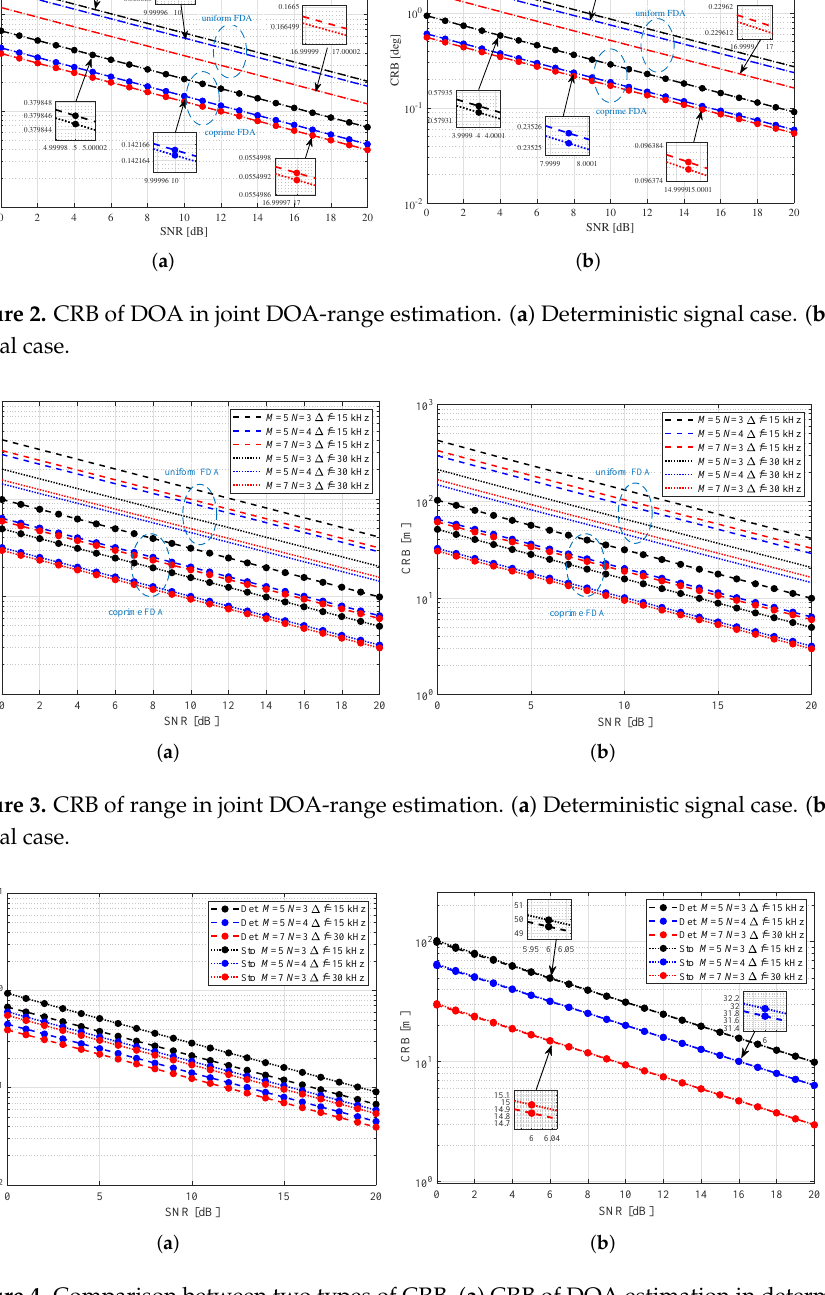
Figure 4. Comparison between two types of CRB. ( a ) CRB of DOA estimation in deterministic case and stochastic case. ( b ) CRB of range estimation in deterministic case and stochastic